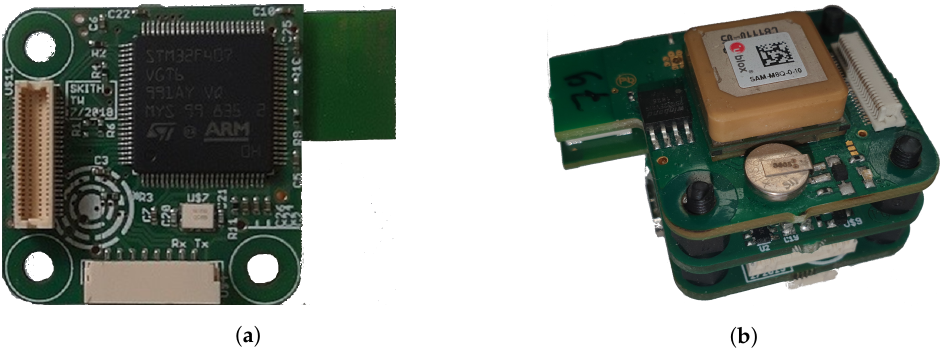
Figure 2. ( a ) The sensor/actuator HW base board with a STM32F4 microcontroller and a DWM1000 ultra-wideband transceiver. ( b ) Base board with daughter board extensions to form a GPS sensor node